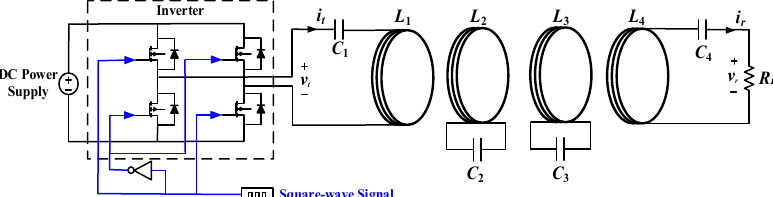
Figure 7. Schematic of the experimental setup.